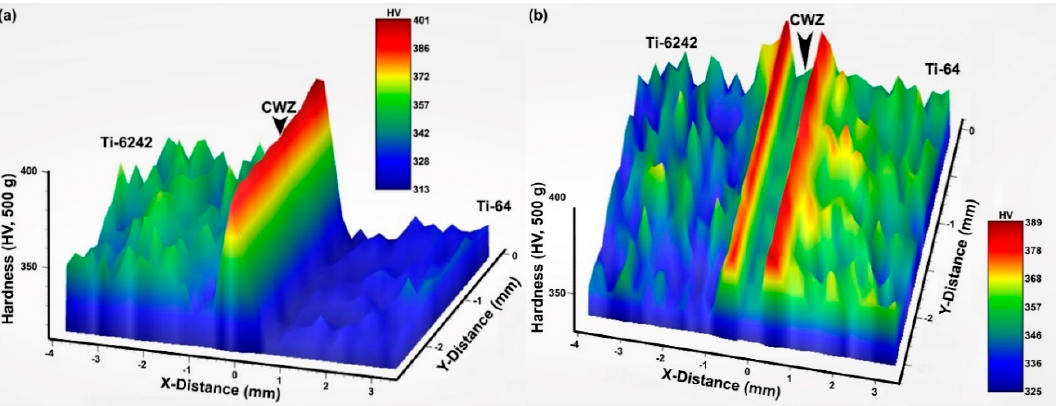
Figure 10. 3D microhardness maps across the dissimilar linear friction welds between Ti-64 and Ti-6242 in ( a ) AWed and ( b ) SRAed conditions.